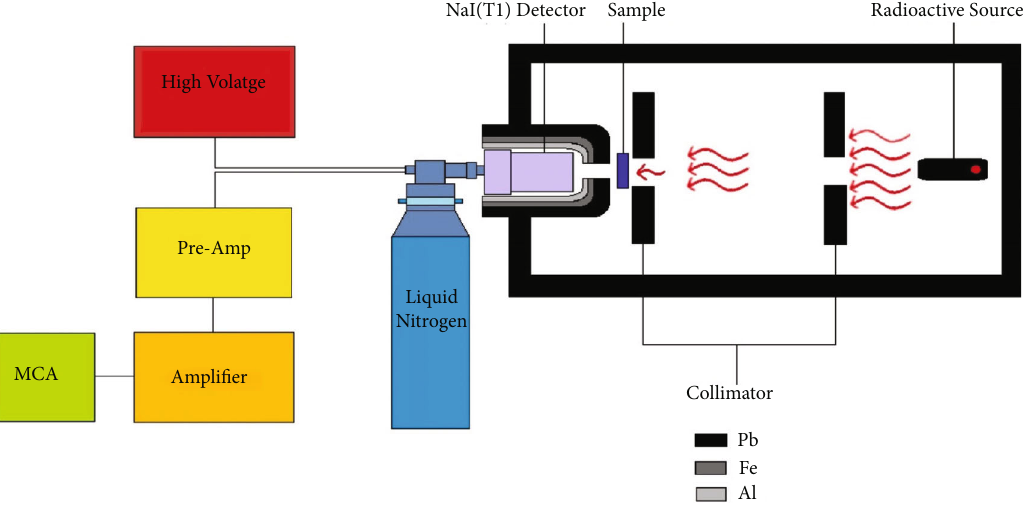
Figure 2: Narrow beam setup for radiation